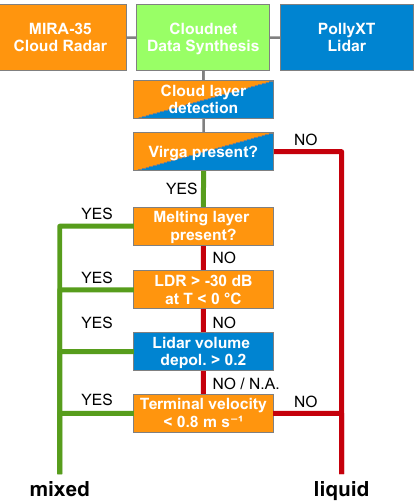
Figure 2. Flowchart of the mixed-phase cloud discrimination method from Bühl et al. (2013) as it is applied in the current work. Most clouds are successfully analyzed with combined